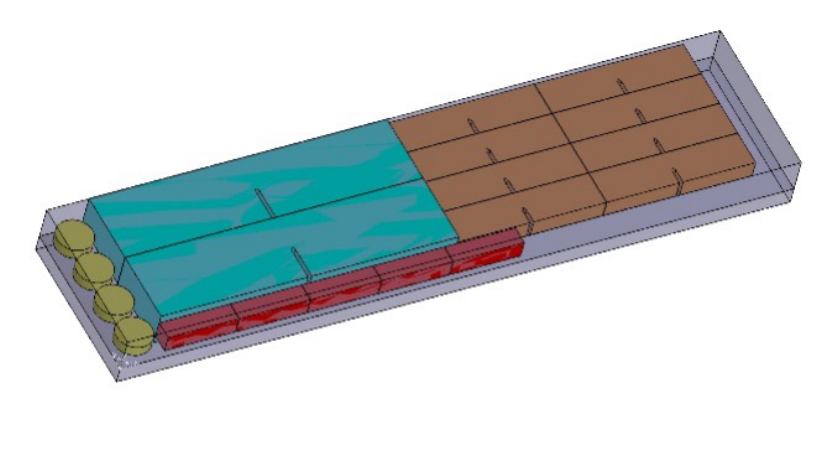
Figure 6. Cutting -plan for samples based on quality of layers. Table 1. Samples produced with their repective dimension and